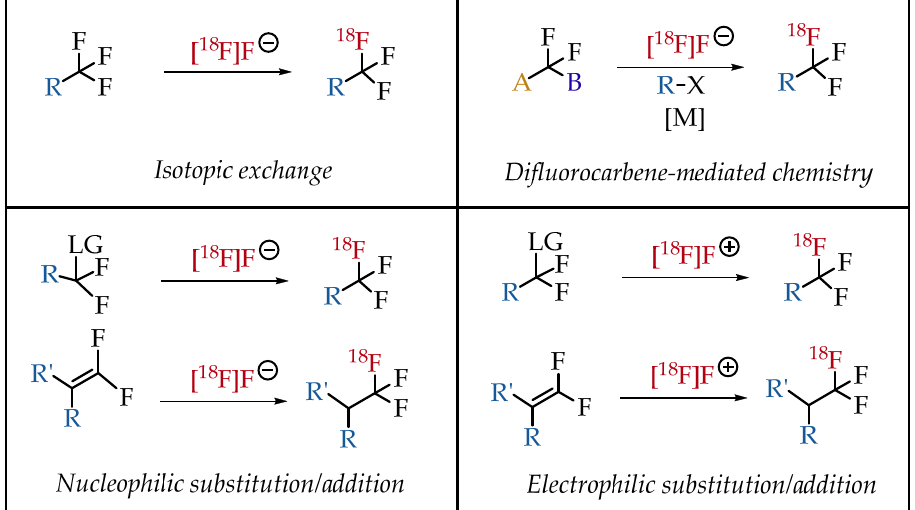
Figure 5. General synthesis strategies for the generation of [ 18 F]CF 3 groups.